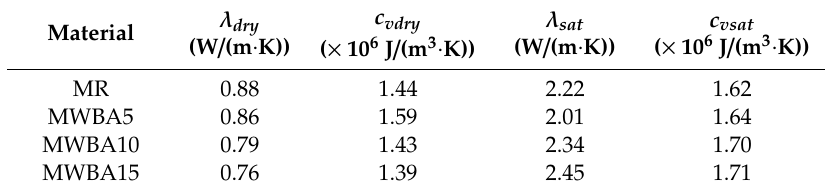
Table 13. Heat transport and storage properties.